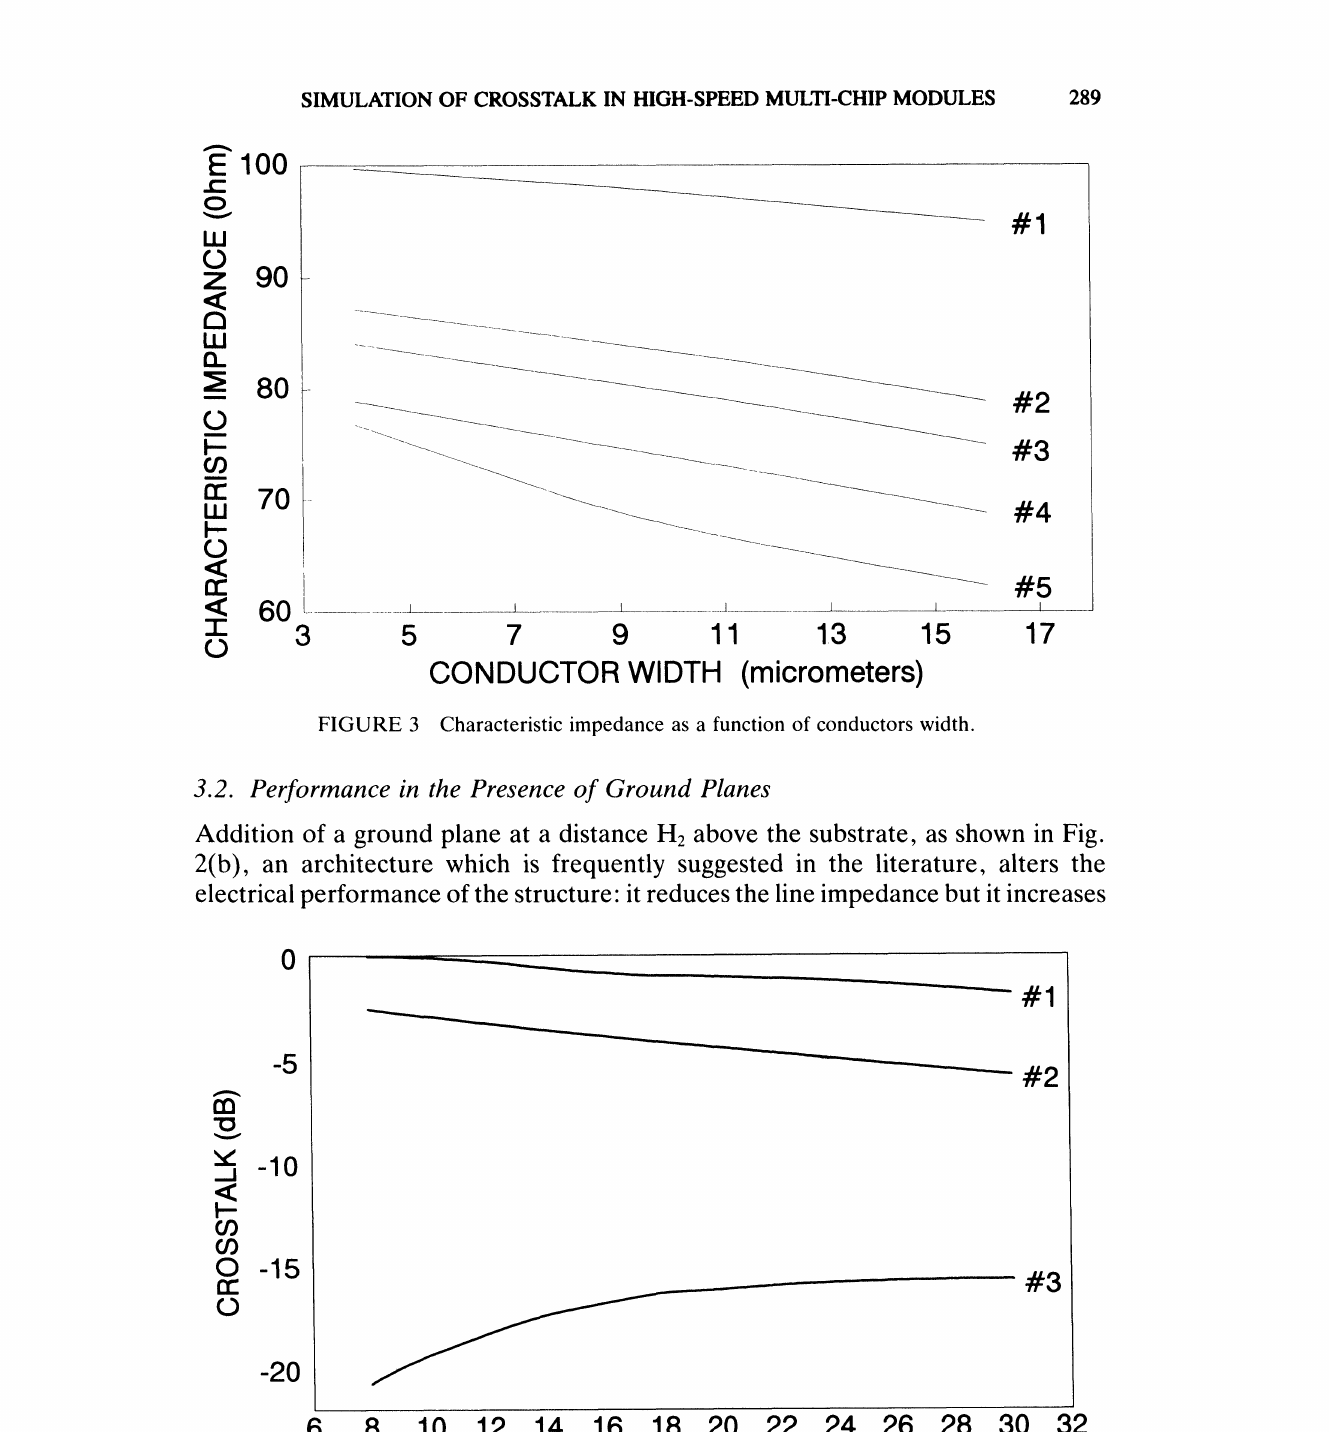
FIGURE 4 Crosstaik as a function of conductors spacing for architectures 2(a), 2(b),